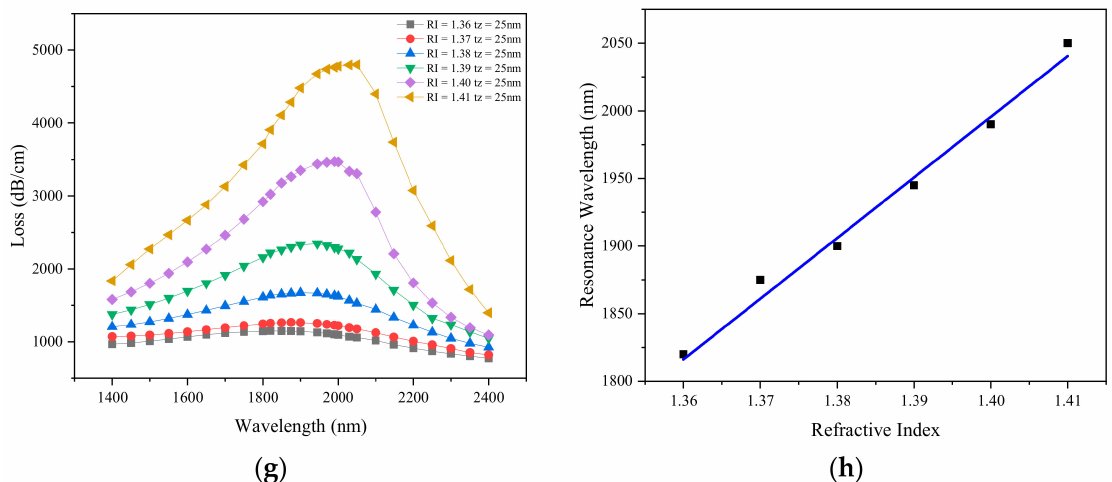
Figure 6. Loss spectra obtained by simulation at analyte RI of 1.37–1.41 when zinc oxide thickness is ( a ) 10 nm; ( b ) 15 nm; ( c ) 20 nm; ( d ) 25 nm; Linear fitting of resonance wavelength with analyte RI from 1.37 to 1.41 by simulation when zinc oxide thickness is ( e ) 10 nm; ( f ) 15 nm; ( g ) 20 nm; ( h ) 25 nm. ( d 1 = 0.5 µ m, d 2 = 0.7 µ m, d 3 = 1 µ m, Λ = 2 µ m, ts = 30 nm).